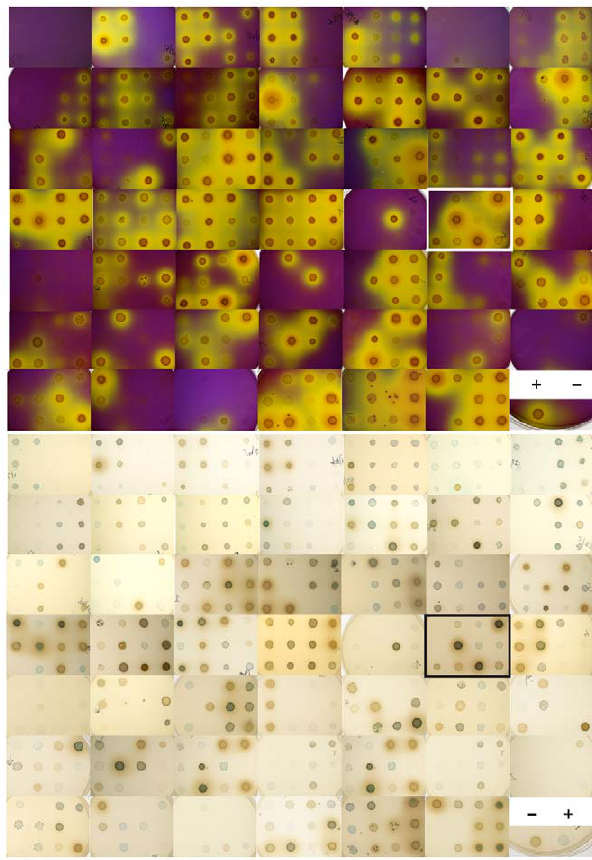
Figure 4. Phenotypic analysis of primary Nairobi isolates. Acid production indicated by yellow colour on mBM medium with mannose as the only carbon source (top), and H 2 O 2 production indicated by blue colour on mBH2 medium with both glucose and mannose (bottom) for 576 isolates from 96 individuals. Note ‘‘double strong’’ isolates in highlighted panel, resembling phenotype of probiotic strains. Positive and negative controls were run on each plate (examples shown in bottom right-hand